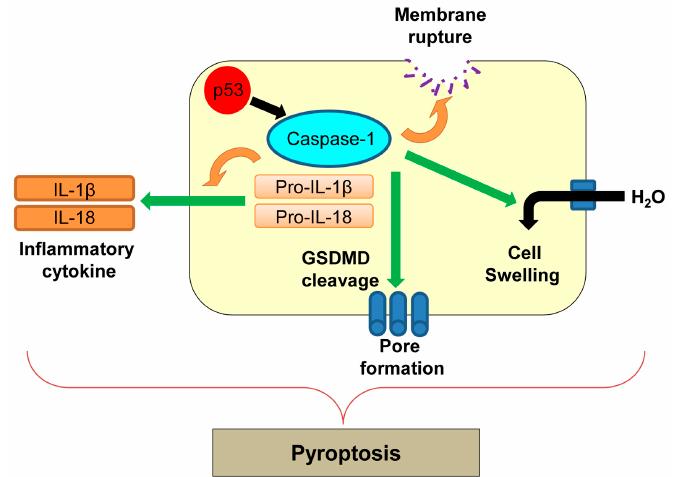
Figure 7. Caspase-1-mediated pyroptosis. p53 transcriptionally upregulates caspase-1, which could activate pyroptosis. GSDMD: gasdermin D; IL: interleukin.